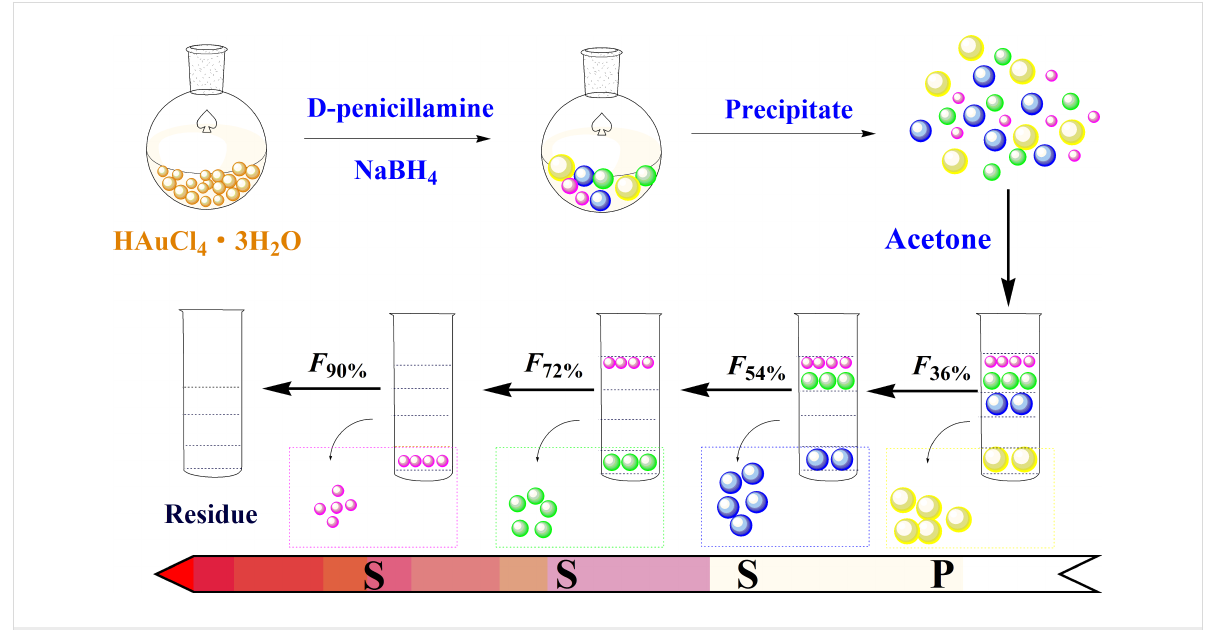
Figure 1: The scheme of the synthesis and fabrication of gold